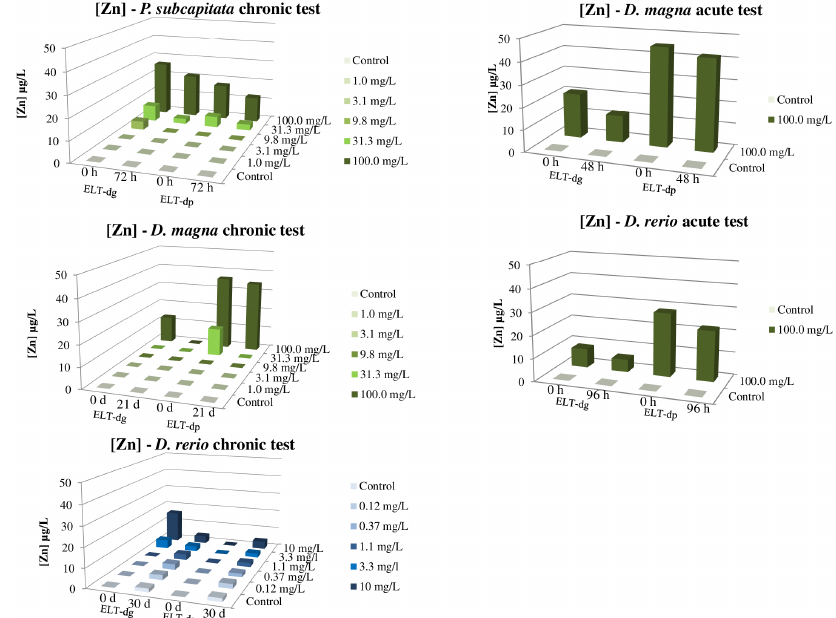
Figure 2. Zn versus ELT-dg and ELT-dp concentrations in the suspensions used in the different ecotoxicological tests at the beginning (t = 0) and at the end of each exposure. The concentration of Zn at t = 0 (fresh suspension) corresponds to Zn directly released by ELT-dg and ELT-dp in water (RSD range for groups of P. subcapitata = 0.22–1.43%; RSD range for groups of D. magna = 0.16–2.91%; RSD range for groups of D. rerio =